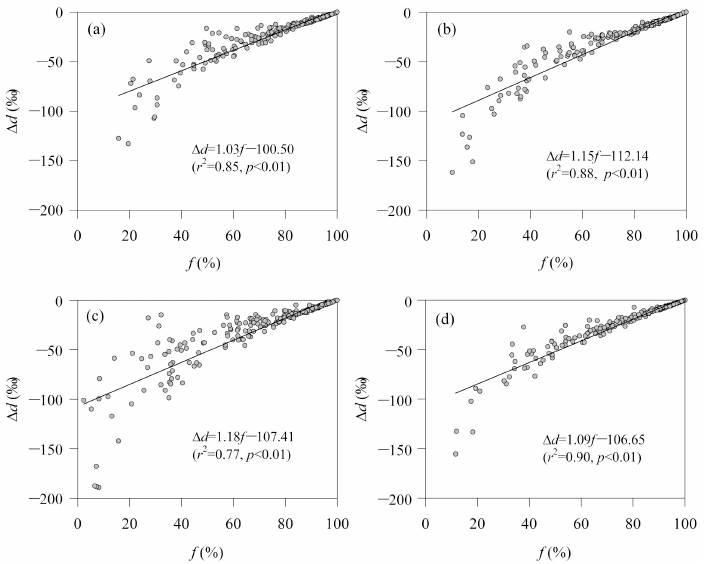
Figure 12. Relationships between f and Δ d in precipitation in 2011 ( a ), 2012 ( b ), 2013 ( c ) and 2014 ( d ).